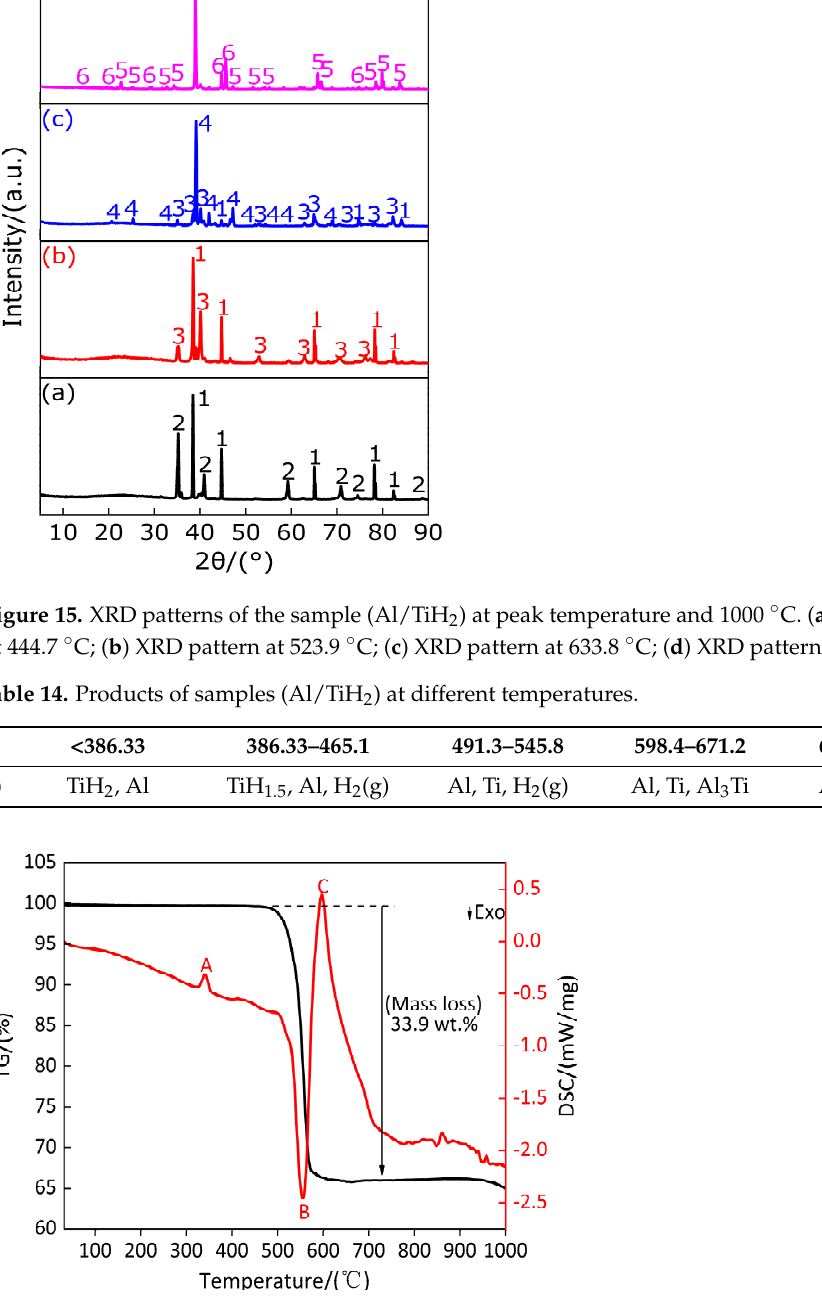
Figure 16. TG/DSC curve of PTFE/TiH 2 composite. A and C: Endothermic; B: Exothermic peak. Table 15. Parameters of peak A, B and C on DSC curve of sample (PTFE/TiH 2 ).